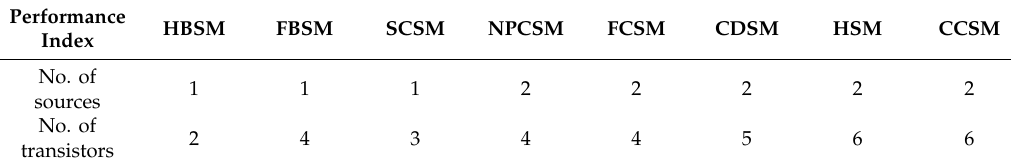
Table 1. Comparison between different SM topologies.